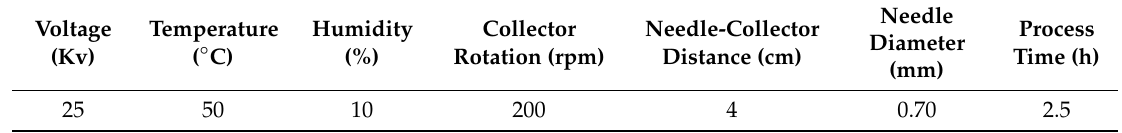
Table 1. Electrospinning